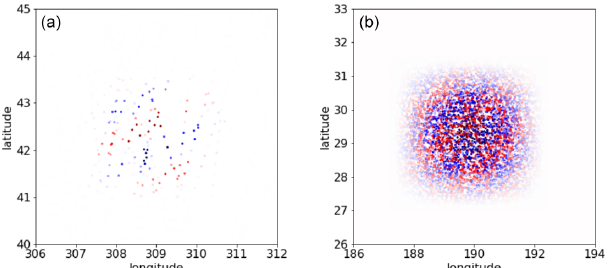
Figure 5. Illustration of the same elements as presented in Fig. 3 (from the mesoscale basis on the left and from the internal tide basis on the right), visualized in the observation space. The colored dots represent the non-zero values of a column of the G